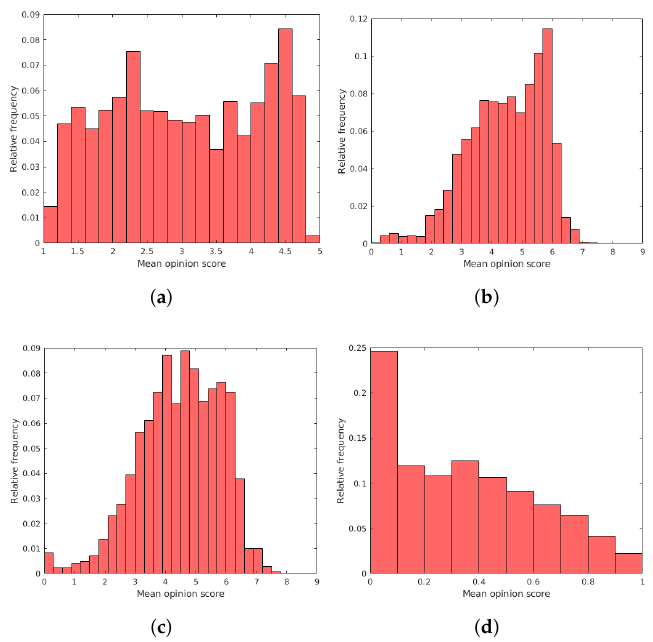
Figure 5. Empirical MOS distributions in the used benchmark IQA databases: ( a ) KADID-10k [5], ( b ) TID2013 [3], ( c ) TID2008 [56], and ( d ) CSIQ [57].